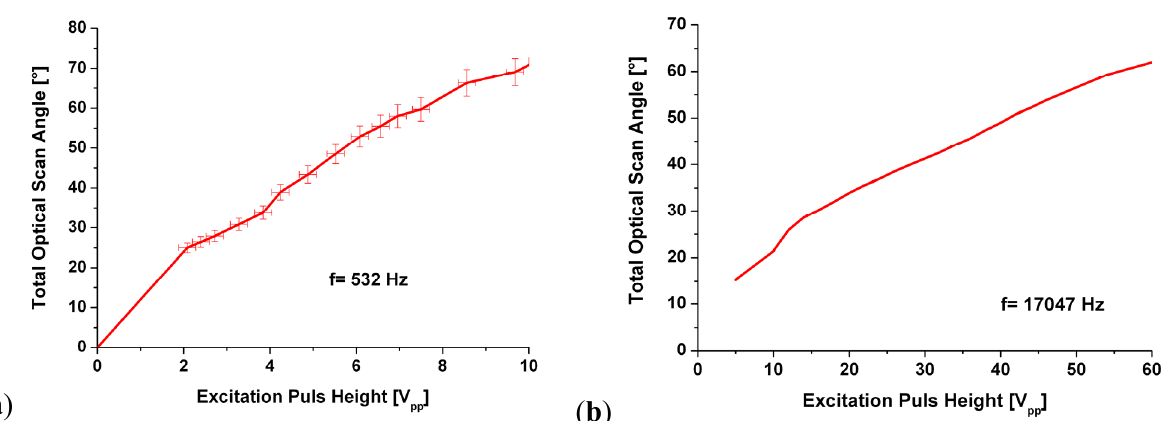
Figure 17. Total optical scan angle as function of driving voltage for gimbal ( a ) and mirror ( b